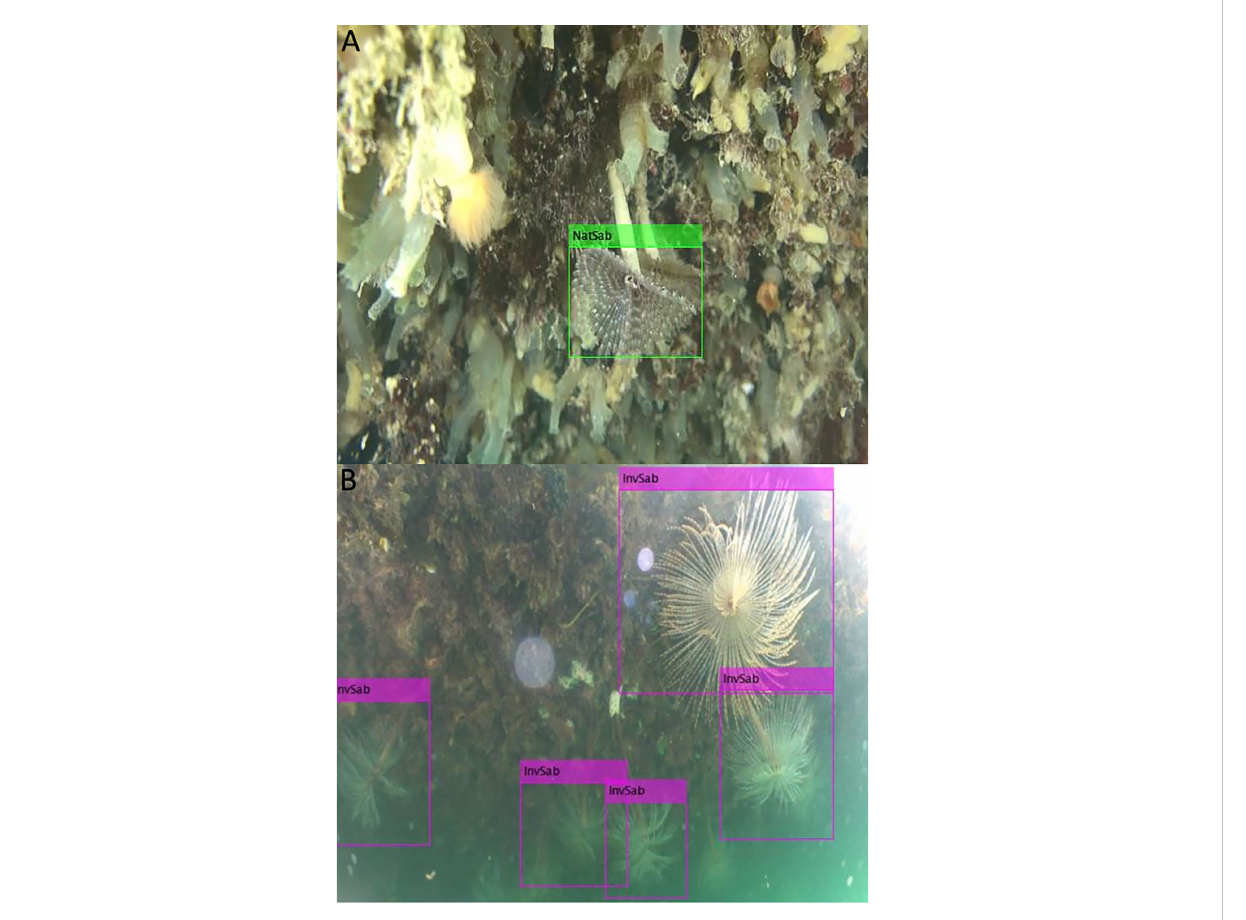
FIGURE 3 Example frames of video-based detectors and detections of the indigenous sabelllid tubeworm Pseudobranchiomma grandis (A) and the non- indigenous Sabella spallanzanii (B)